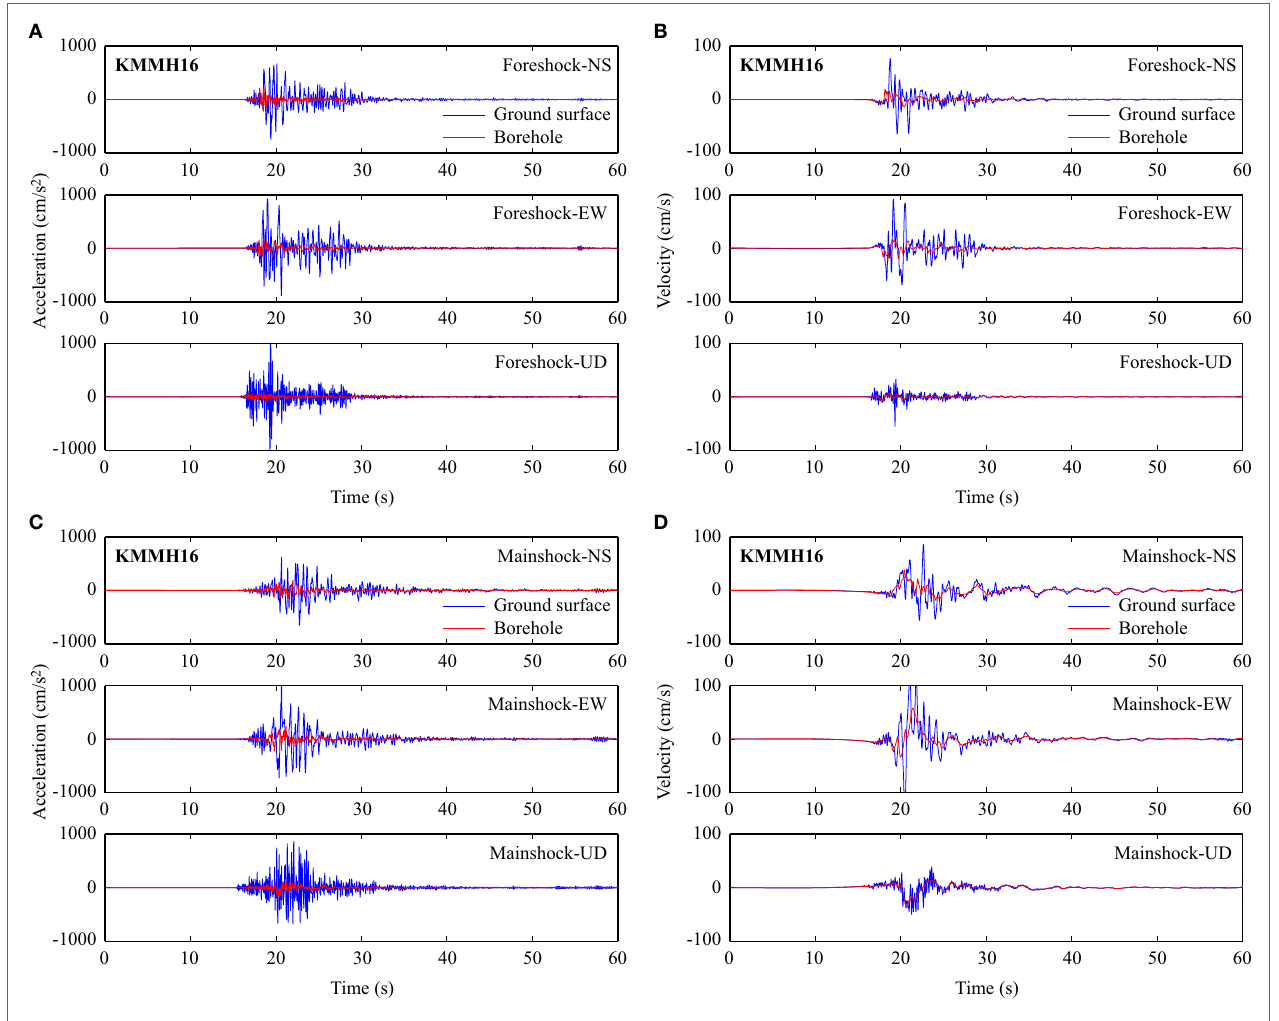
FigUre 5 | (a) Acceleration time-histories for the foreshock at KMMH16. (B) Velocity time-histories for the foreshock at KMMH16. (c) Acceleration time-histories for the mainshock at KMMH16. (D) Velocity time-histories for the mainshock at